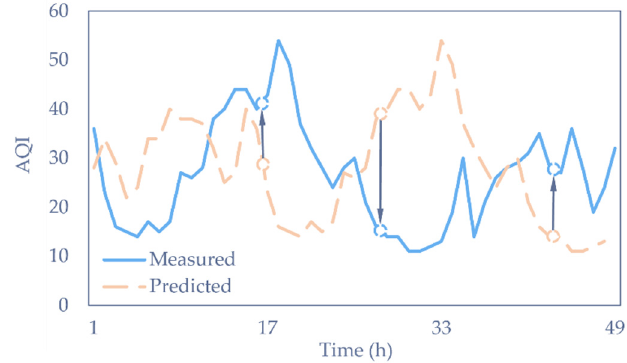
Figure 8. Prediction of the persistence model for 48 h. Table 4. Metrics of the auto-modal and prediction models with different prediction lengths.